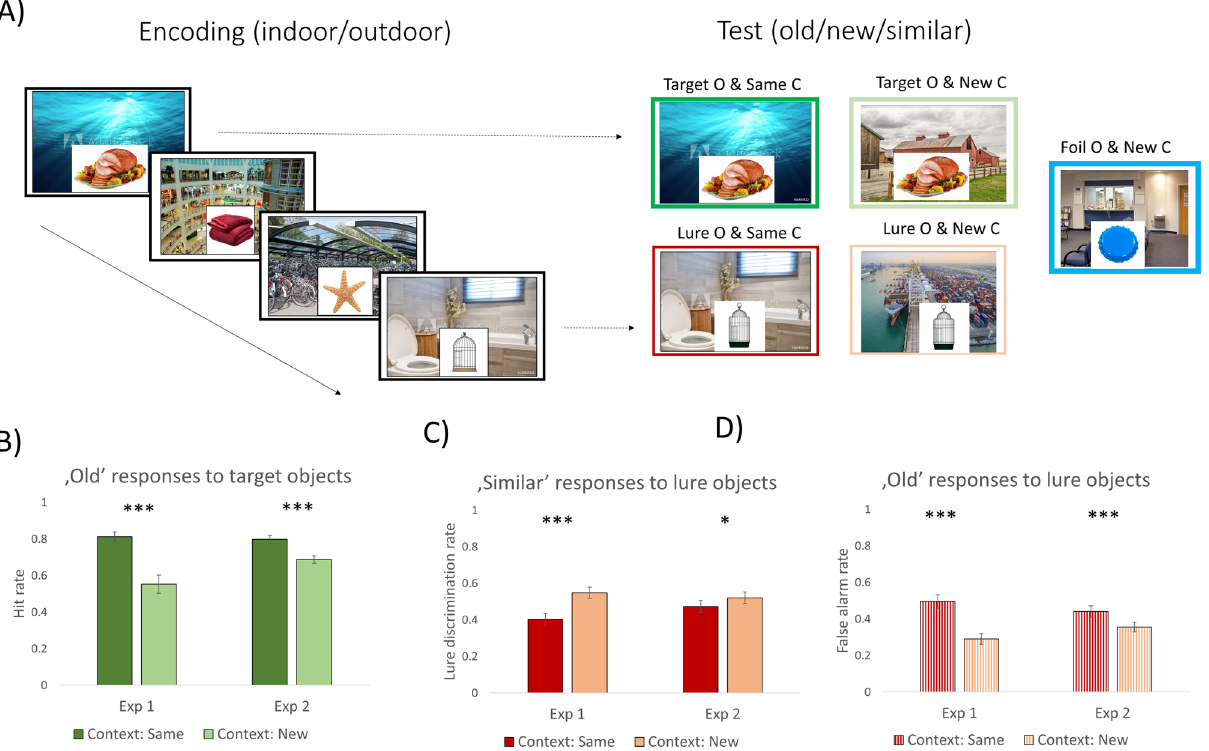
Figure 1. The procedure ( A ) and the results (‘ B ’, ‘ C ’, ‘ D ’) of Experiment 1 and Experiment 2. Note(s). In both experiments (‘ A ’), participants made indoor/outdoor judgements on photographs of everyday objects presented on a background of scene images. They were specifically instructed to judge the objects only. Later, in a surprise recognition memory task, these original target objects were presented together with similar lure objects and completely new foils. Each target and lure object was presented either on the same or on a new background context. Participants were instructed to make an “old”/“similar”/“new” decision. In Experiment 2, participants were explicitly instructed to make their judgements based on the object, whereas in Experiment 1 no such instruction was given. (Experiment 1: N = 28; Experiment 2: N = 40; O: Object; C: Context.) We investigated whether context type affects the ratio of “old” responses given to the target objects (‘ B ’) as well as the ratios of “similar” (‘ C ’) and “old” (‘ D ’) responses given to the lure objects. Error bars represent the standard error of the mean. *p < 0.05; ***p <